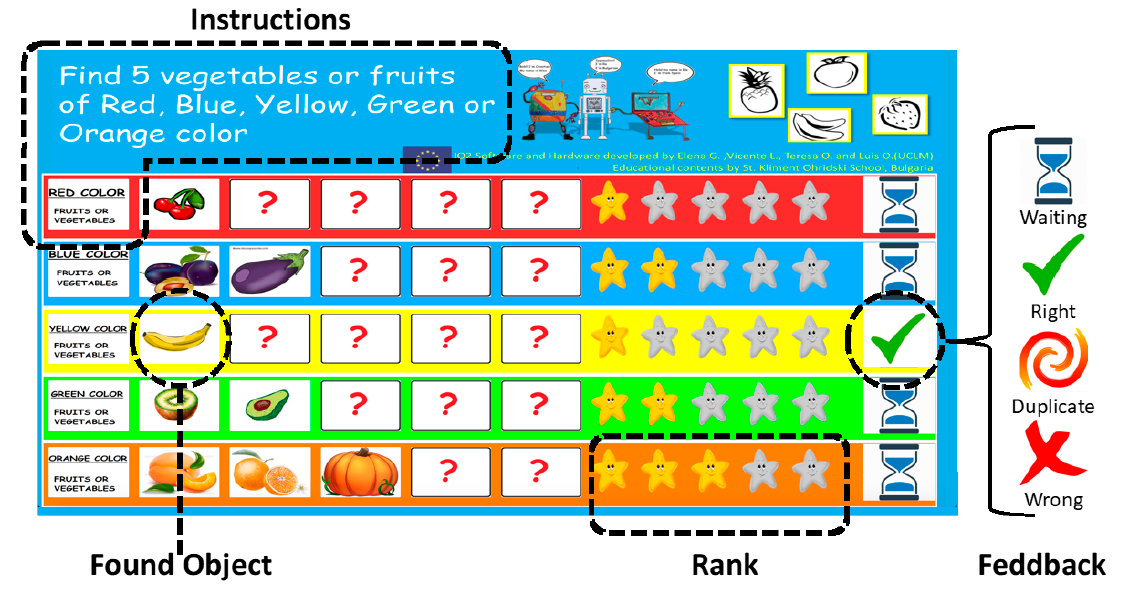
Figure 5. Main App